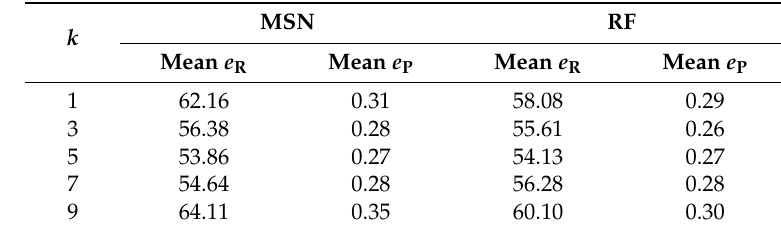
Table 7. The selection results of neighbor number k for MSN and RF imputation with SET1 (V, G, H, DBH, N).